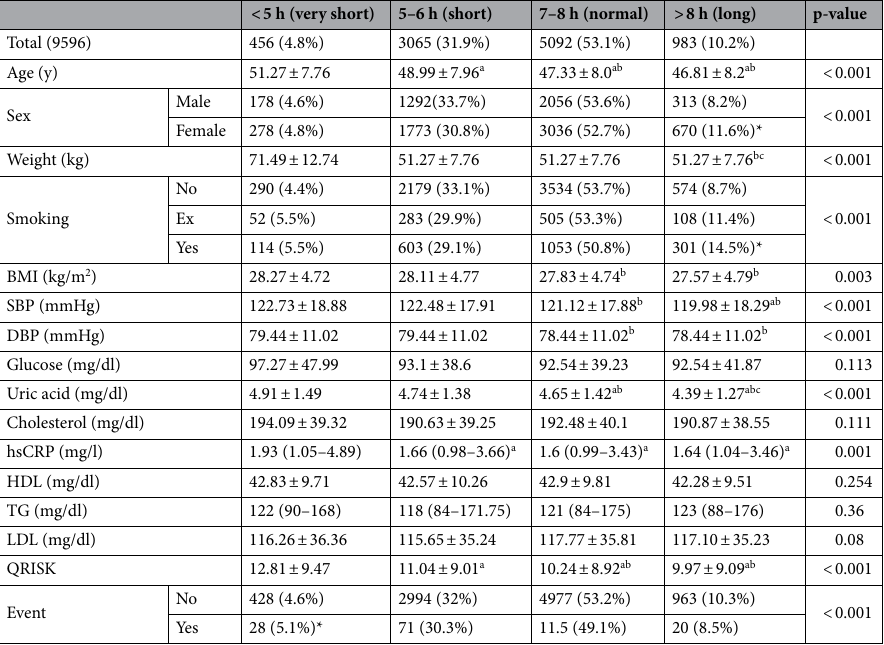
Table 1. Demographic and biochemical characteristics of subjects according to nightly sleep. Data are presented as the mean (SD) or interquartile range. Differences in variables among nightly sleep determined using ANOVA analyses. a < 5 h vs 5–6 h, 7–8 h and > 8 h. b 5–6 h vs 7–8 h and > 8 h; 7–8 h vs > 8 h.